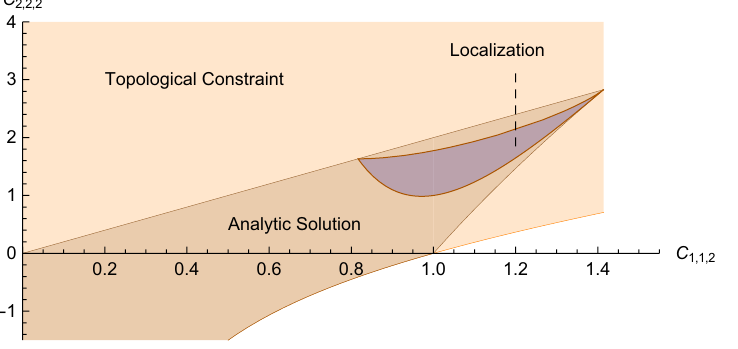
Figure 9 . Allowed region for C 1 ; 1 ; 2 , C 2 ; 2 ; 2 from the topological contraint (which coincides with the numerical analysis for small values of the gaps above the unitarity bounds). There is a general p upper bound on C 1 ; 1 ; 2 , namely C 1 ; 1 ; 2 (cid:20) 2, but there is no upper or lower bound on C 2 ; 2 ; 2 . On top are the analytical solutions (C.1), and the localization region from formulas (3.7),